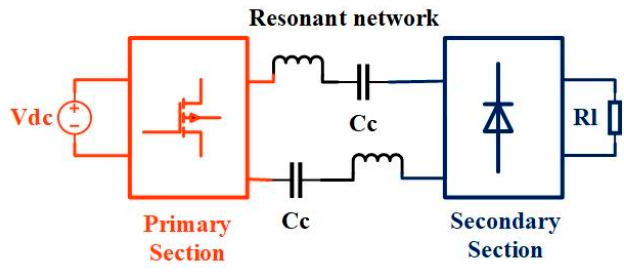
Figure 1. CPT block with resonant network.